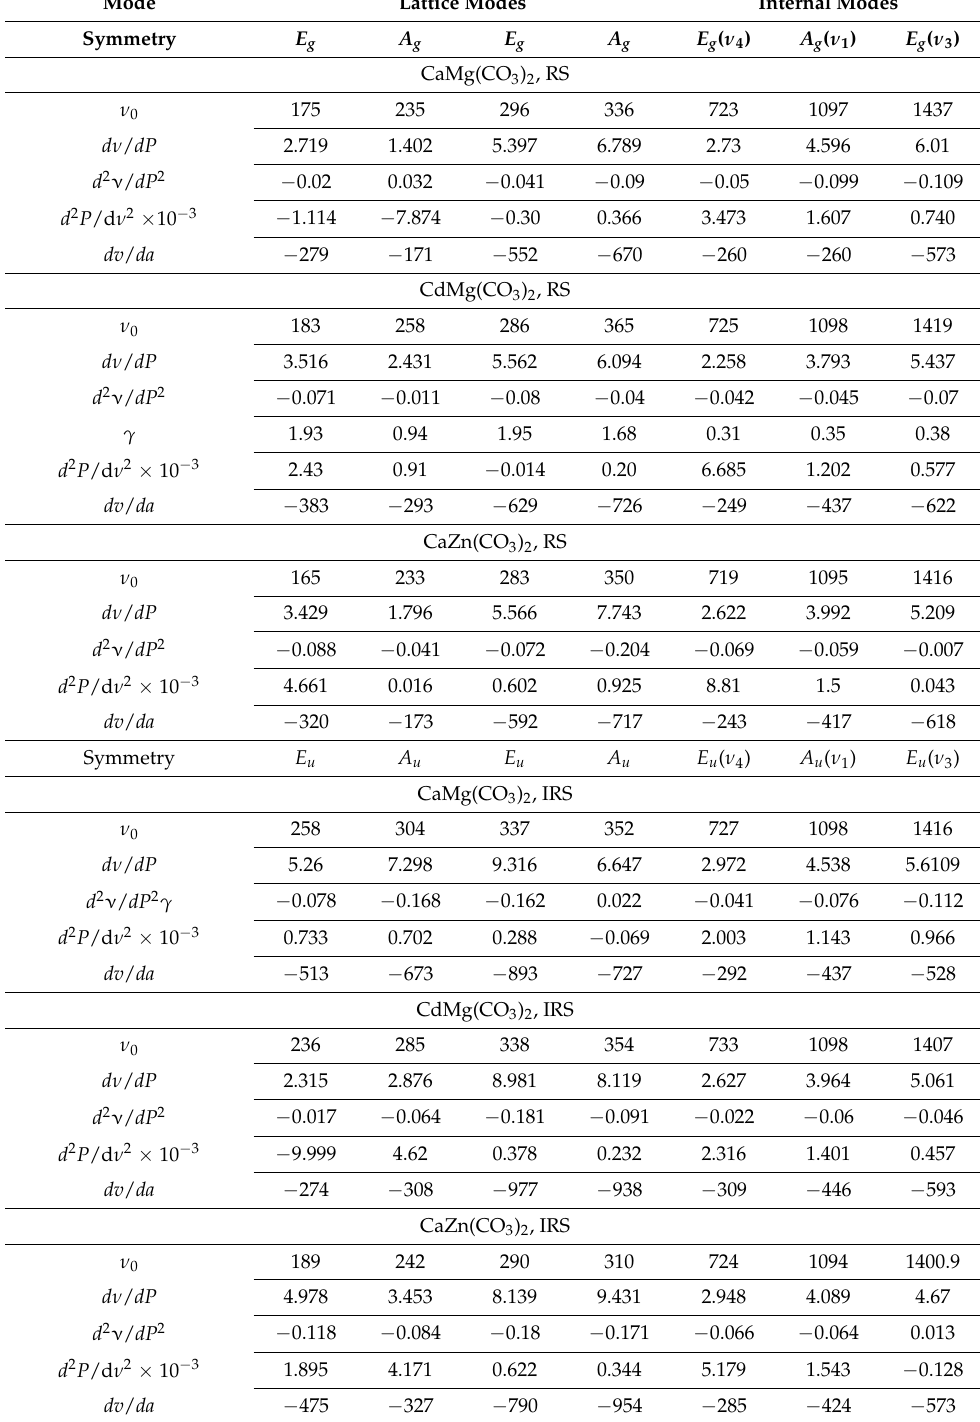
Table 5. Wavenumbers ν 0 (cm − 1 ) of intramolecular modes active in the infrared (IRS) and Raman (RS) spectra of carbonates with a dolomite structure, their first d ν /dP (cm − 1 /GPa) and second d 2 ν / dP 2 (cm − 1 /GPa 2 ) derivatives, with respect to the P pressure; the second pressure derivative, with respect to the wavenumber d 2 P / d ν 2 (GPa 2 /cm − 1 ), and the wavenumber derivative, with respect to the dv / da (cm − 1 /Å) lattice